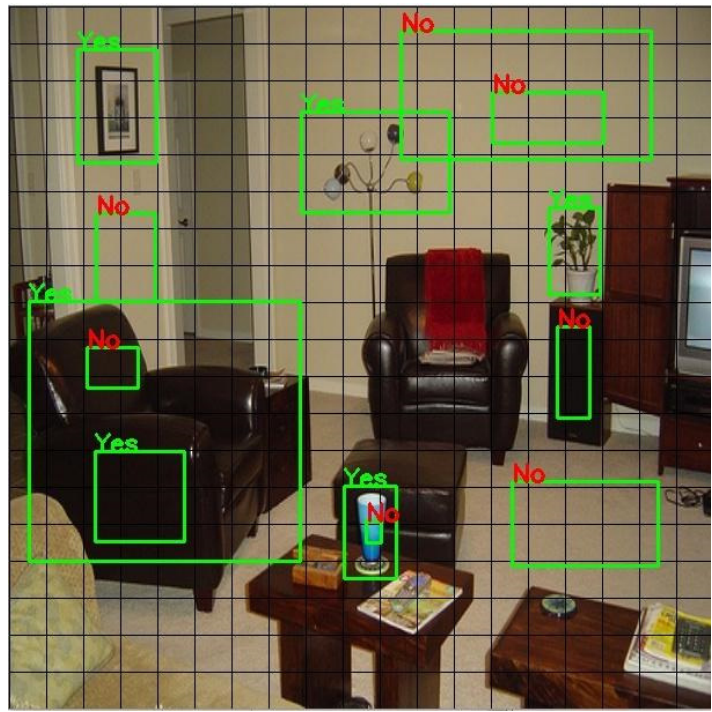
Figure 8. Efficient multi-scale anchor box (Example 1).